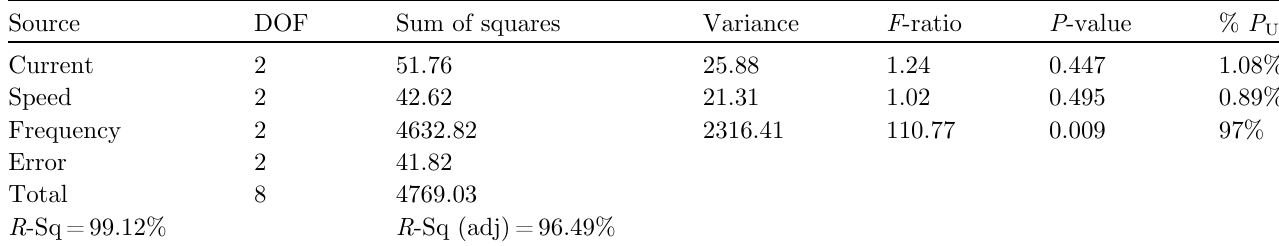
Table 10. Analysis of variance for UTS of L